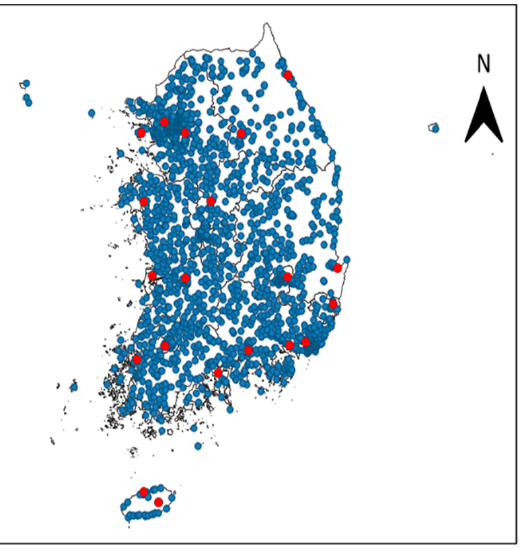
Figure 3. Mapped Korea Post and logistics center locations by QGIS 3.20 Odense software.